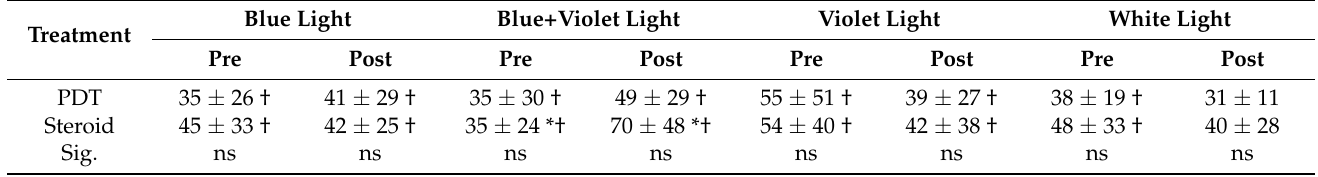
Table 8. Comparison of lesion texture (microcontrast) outcomes treated with PDT and steroid therapy. Treatment